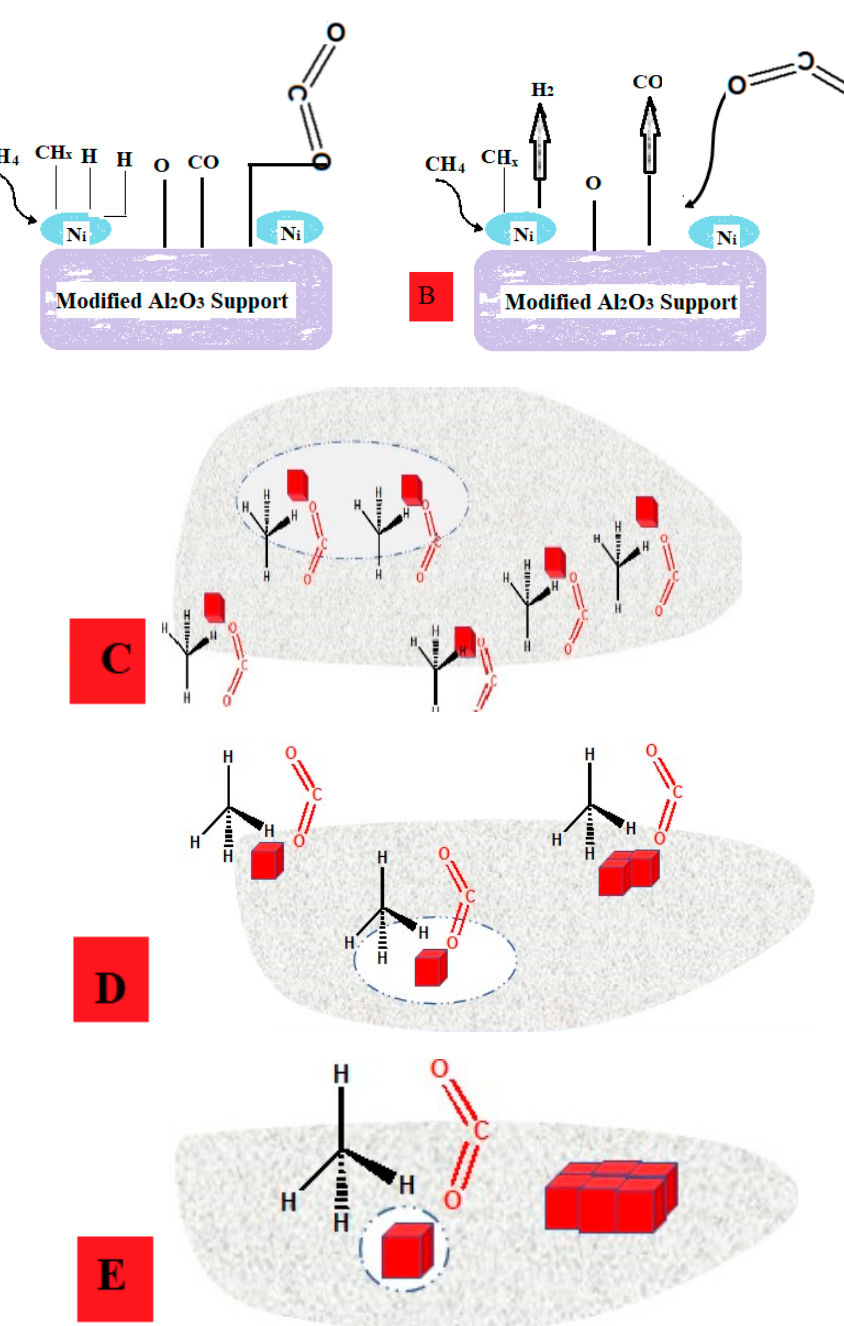
Figure 8. Reaction mechanism for the CRM process. The subfigures ( A – E ) display the stages and the pathways of the